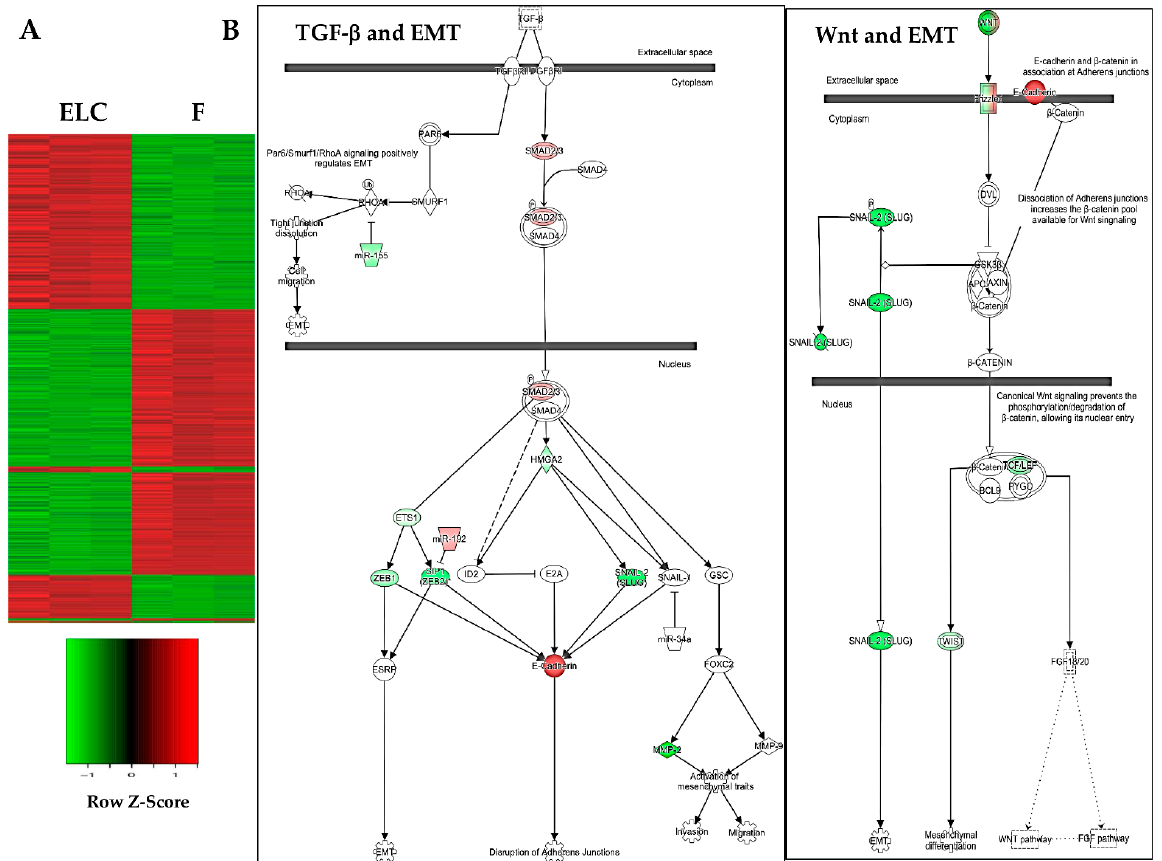
Figure 7. Clustering analysis plot of fibroblasts (F) and derived ELC showing marked changes in pattern-gene expression, with downregulation of canonical TGF- β and Wnt pathways in the ELC derived from fibroblasts. Cluster analysis of fibroblasts and derived ELC. Upregulated and downregulated genes are represented in red and green colors, respectively ( A ). Pathway analysis was performed using ingenuity pathway analysis (IPA) software, as described in the Methods. Transcription factors Snail, Twist, and Zeb were downregulated (green), while E-cadherin was upregulated ( B ).